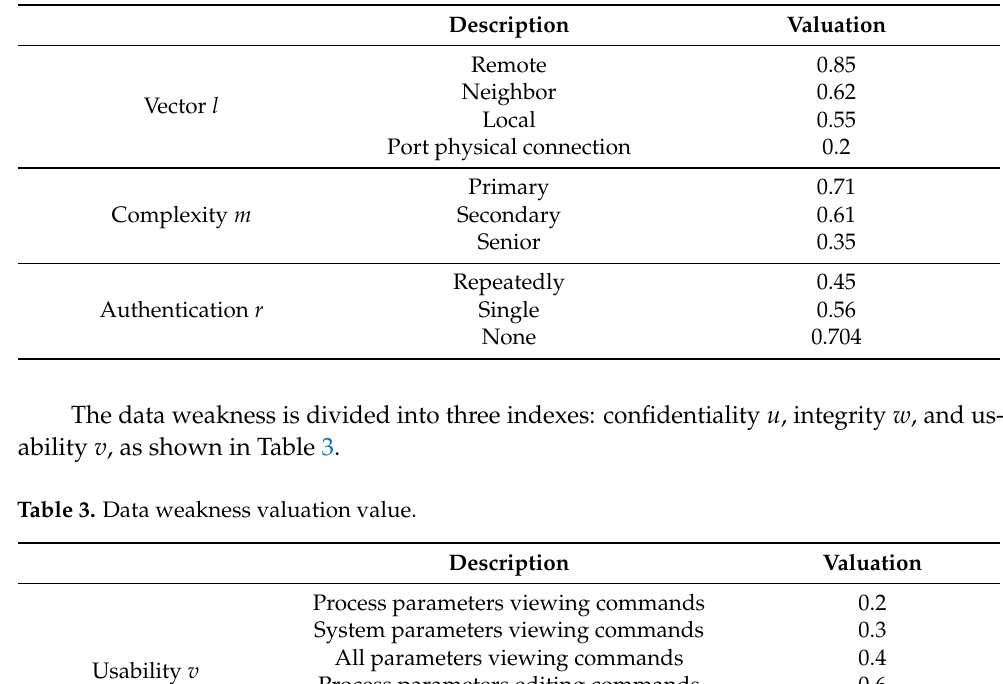
Figure 3. Hierarchy diagram of the vulnerability of ICS. Table 2. The valuation of availability.